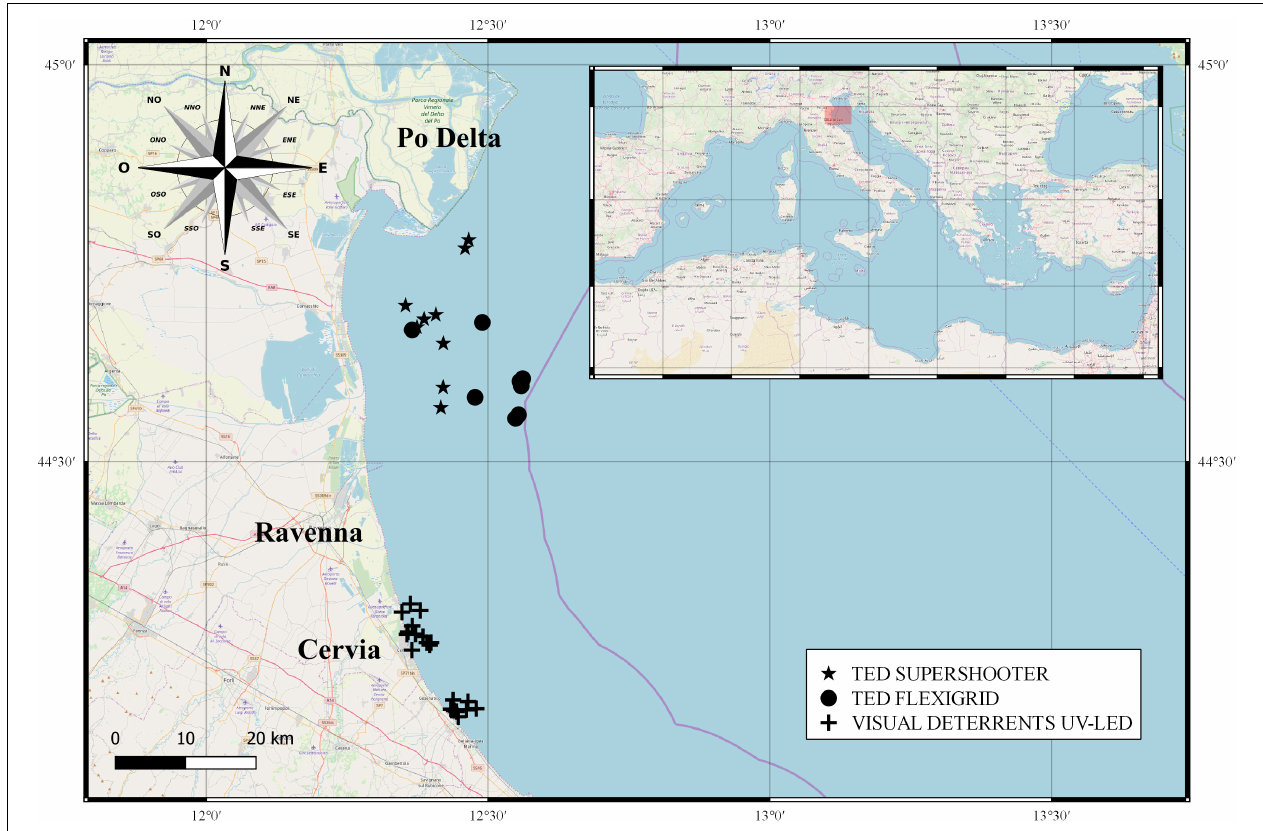
FIGURE 1 | Map of sea trials carried out in North Adriatic Sea with BRDs: sorting grids (TEDs) in bottom trawling and visual deterrents (UV-LEDs) in set net.